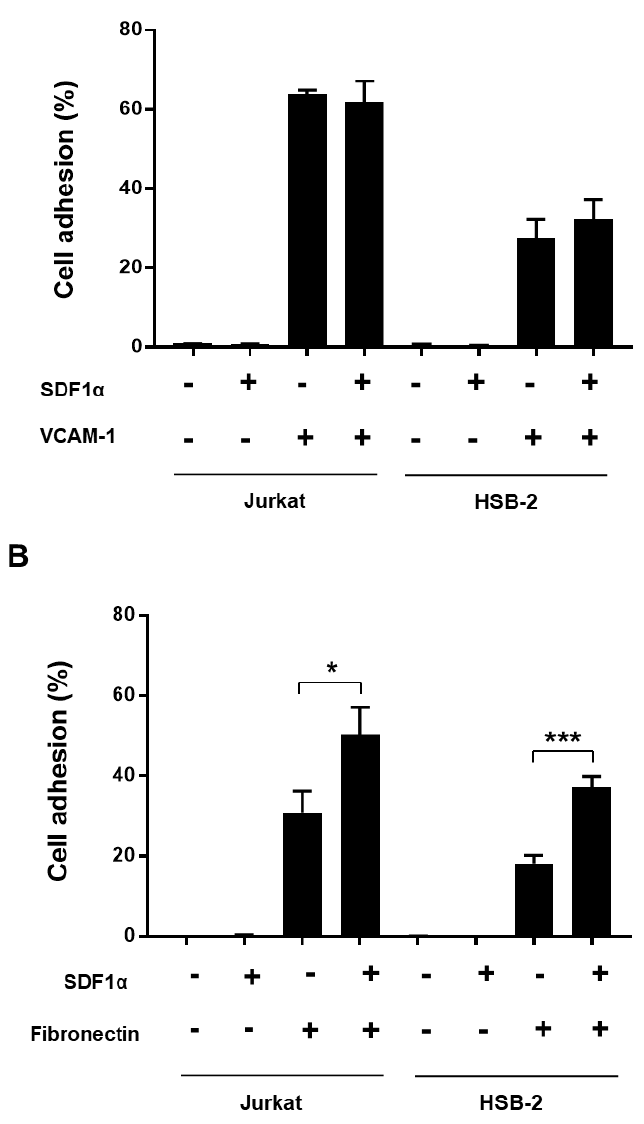
Figure 2. T-ALL cell adhesion to VCAM-1 and fibronectin. Jurkat and HSB-2 cells were pre- activated or not with SDF1α for 1 h and then seeded on wells coated with VCAM-1 ( A ), fi- or not with SDF1 α for 1 h and then seeded on wells coated with VCAM-1 ( A ), fibronectin ( B ) or BSA bronectin ( B ) or BSA ( − ) for 4 h. The cells were washed three times and the remaining cells were ( − ) for 4 h. The cells were washed three times and the remaining cells were counted. Results represent counted. Results represent mean values percentages of adherent cells ± S.D. of three independent mean values percentages of adherent cells ± S.D. of three independent experiments. * p < 0.05 and experiments. * p < 0.05 and *** p < 0.001 determined by the Student’s t -test. *** p < 0.001 determined by the Student’s